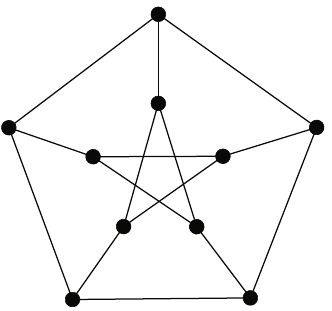
Figure 1: The Petersen graph P